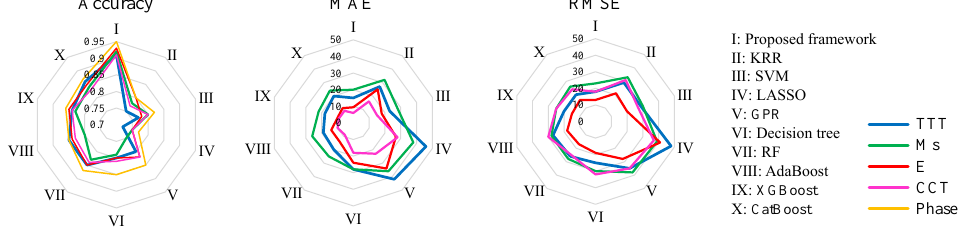
Figure 7. Comparison of testing performance of conventional machine learning methods and pro- posed framework.